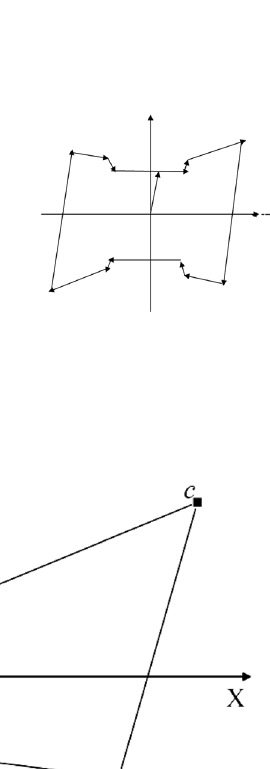
Fig. 9 Decomposition of shoulder region of super-link’s hysteretic loop